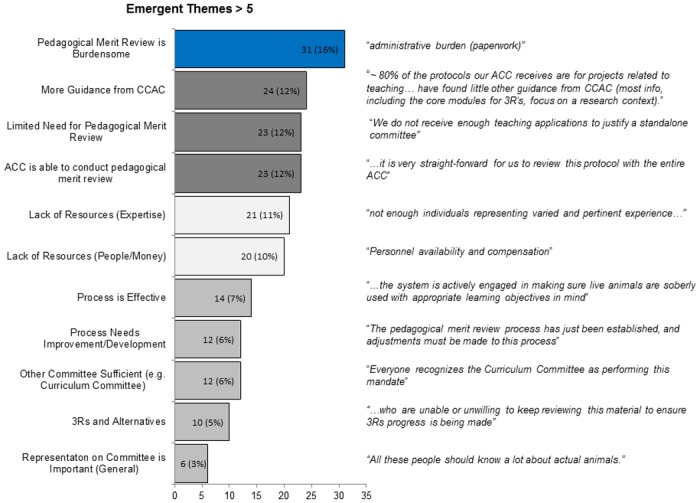
Emergent Themes > 5.